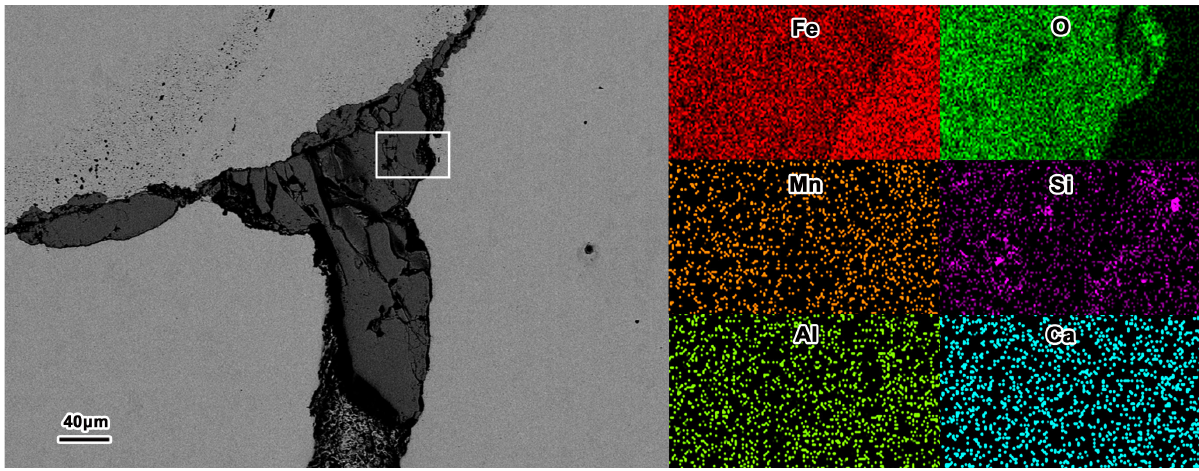
Figure 4: Element mapping of typical reticular crack